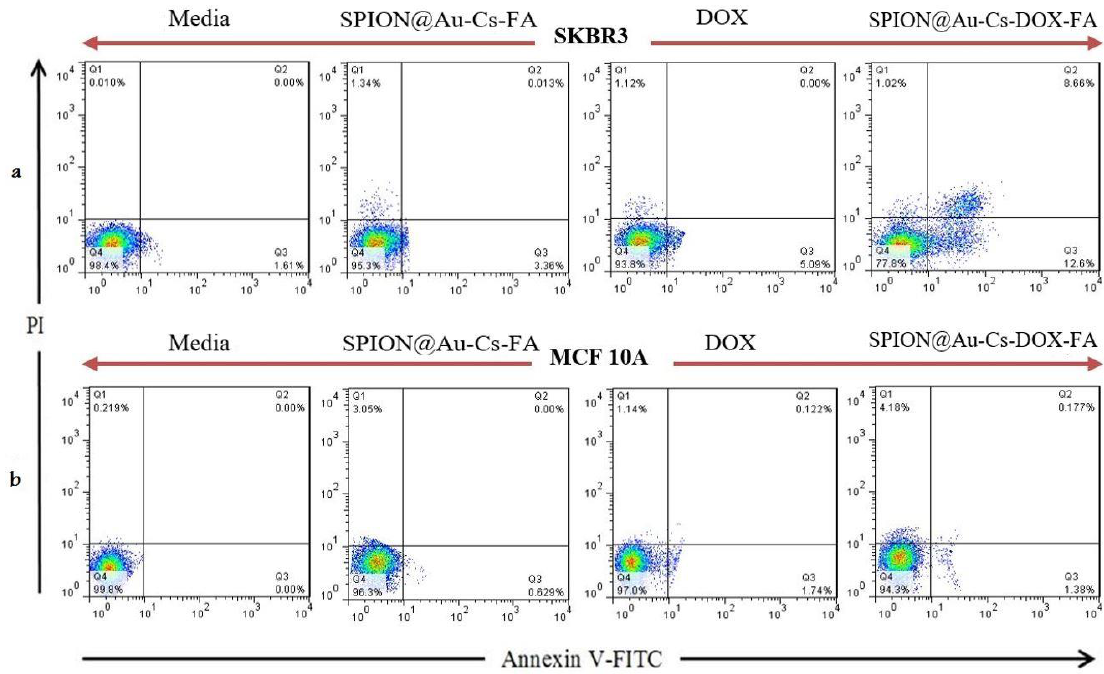
Figure 5. Apoptosis induction of SkBR3 ( a ) and MCF-10A ( b ) cell lines with media (control), bare SPION@Au-CS-FA NPs, free DOX and SPION@Au-CS-DOX-FA. The number of SkBR3 cells undergoing apoptosis significantly increases when treated with SPION@Au-CS-DOX-FA. Treatment of SkBr3 cell line with bare SPION@Au-CS-FA and free DOX separately, indicating that both treatments did not show any remarkable apoptosis induction.